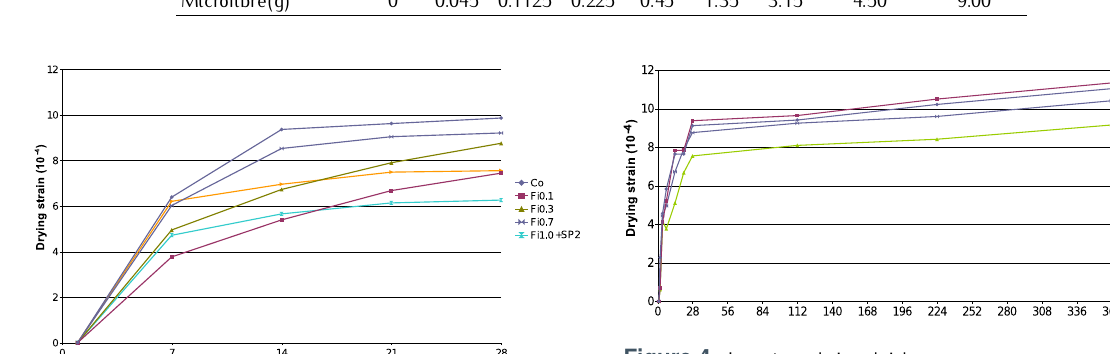
Figure 4. Long-term drying shrinkage.